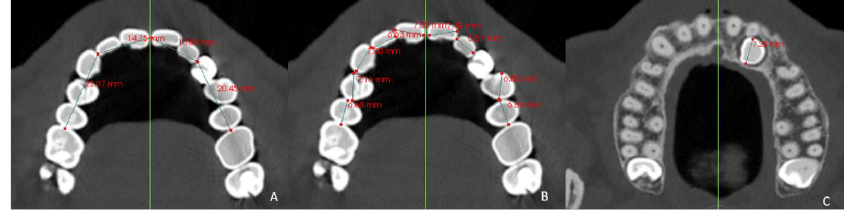
Figure 5. ( A ) Arch length (AL), ( B ) tooth size (TS), and ( C ) tooth size measured in an impacted canine. 2.5. Statistical Analysis